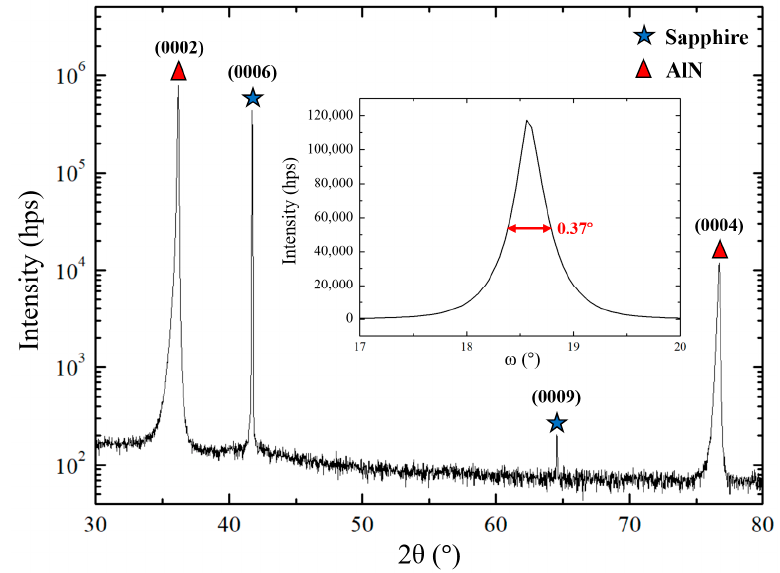
Figure 2. θ -2 θ diagram of an AlN thin film deposited on a 470 °C heated sapphire substrate. The inset figure shows the rocking-curve of the (0002) orientation. Sensors 2020 , 20 , x FOR PEER REVIEW